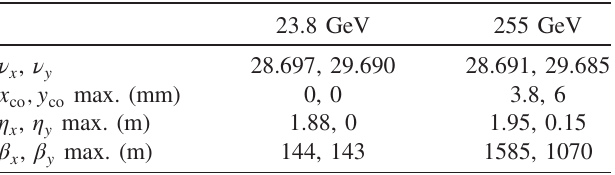
TABLE VI. RHIC Yellow lattice, including field maps of snakes and STAR rotators. Optical parameters at store